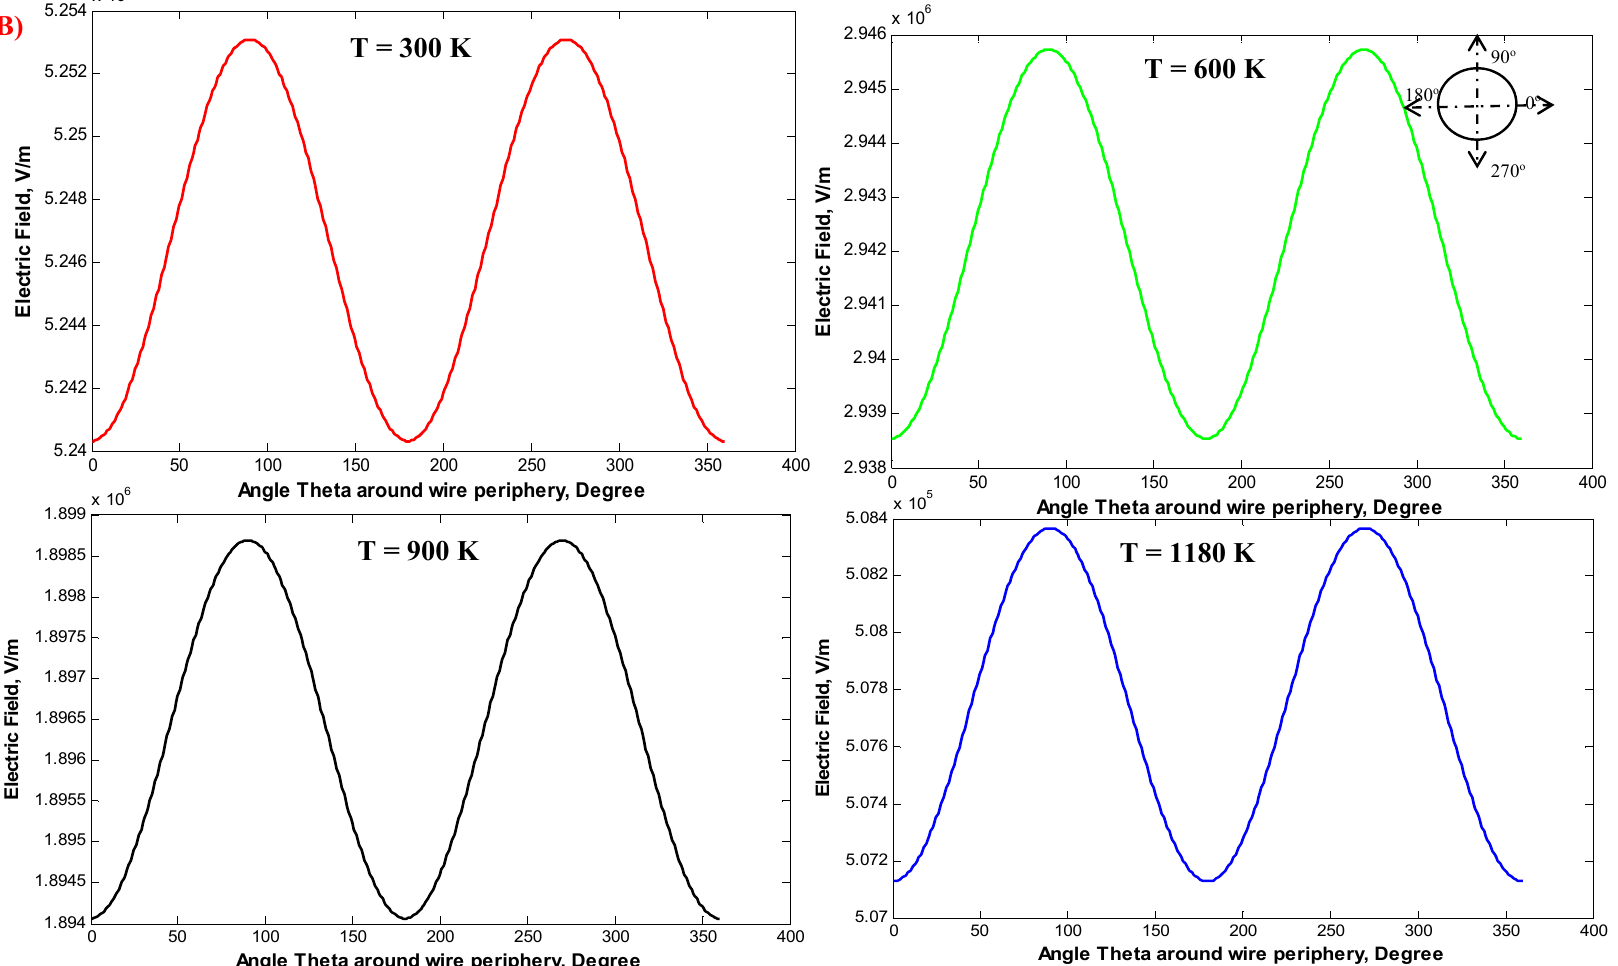
Figure 17. Distribution of the electrostatic field around the central wire of the multi-discharge wire WDESP (seven-wire): ( A ) rc = 0.935 mm, Vo = 37.429 kV; and ( B ) rc = 1.975 mm, Vo = 59.123 kV.